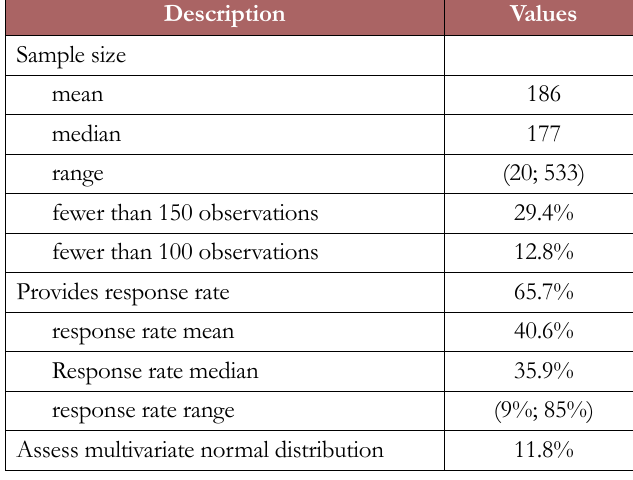
Table 5. Data characteristics